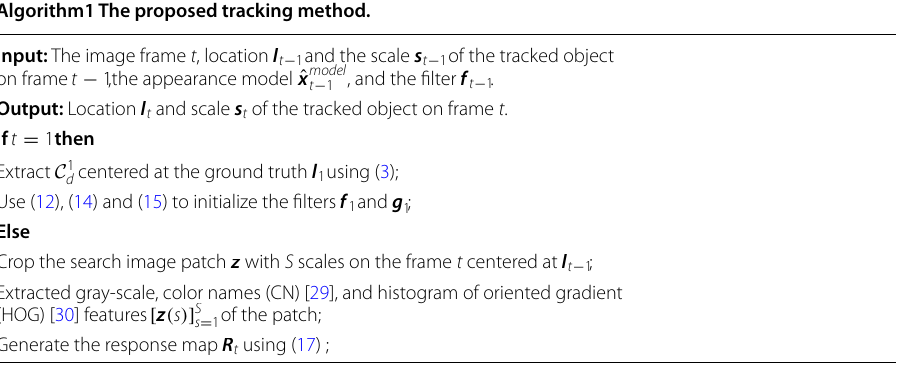
Algorithm1 The proposed tracking